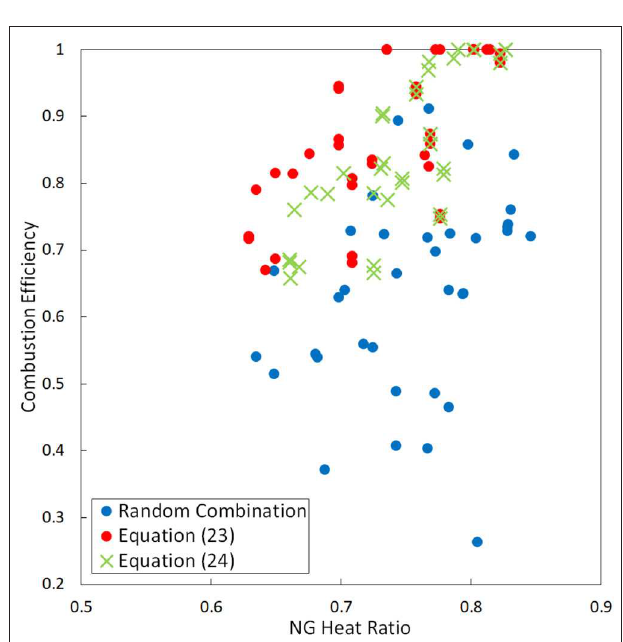
FIGURE 10 | Relation between combustion efficiency and the heat ratio of natural